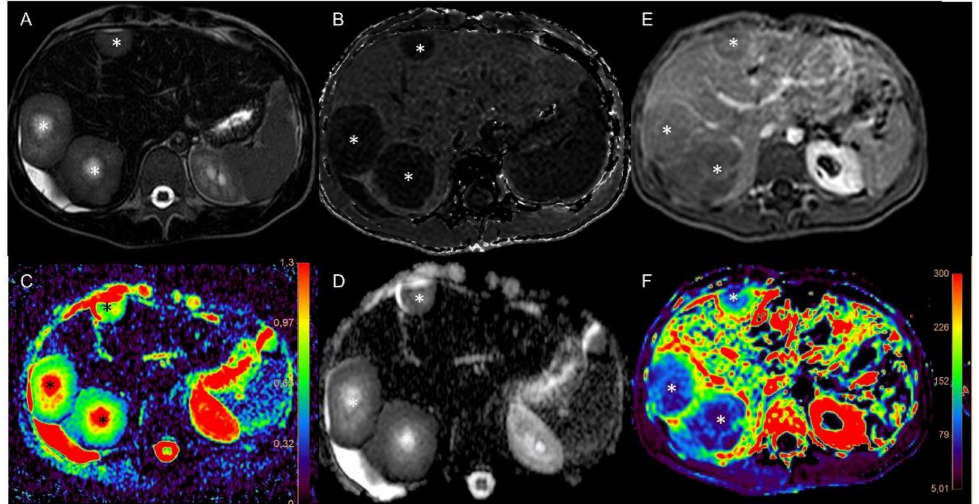
Figure 2. Exemplary imaging data. Imaging of patient 13 with a desmoplastic round cell tumor with multiple liver metastases (marked with an asterisk) before therapy. ( A ) T2 for anatomical information, ( B ) T2* after injection of ferucarbotran for calculation of VVF, ( C ) ADC map, ( D ) ADC, ( E ) DCE scan after injection of gadobutrol, ( F ) calculated K-trans map. The imaging protocol thus comprises different sequences to first acquire anatomical information, followed by different possibilities for the assessment of tumor perfusion and its changes after therapy. Color scale in C represents the ADC value, color scale in F represents the k-trans value.